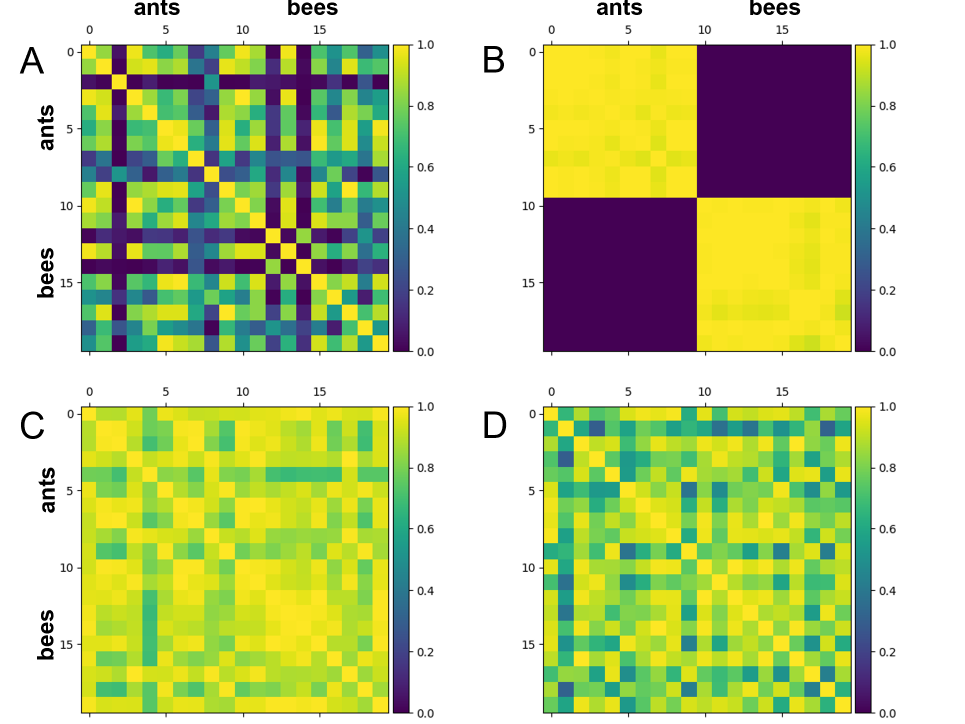
Figure 2. Gram matrices for mutual data overlap (i.e., | (cid:104) x | x (cid:48) (cid:105) | 2 ) in Hilbert space for 10 ant and 10 bee samples from the Hymenoptera dataset where 0 and 1 correspond to no and perfect overlap, respectively. In each case, 512 ResNet features (corresponding to 1024 trainable linear parameters) were used. The stronger the separation between the purple tiles (bees) and the yellow tiles (ants), the better the model’s ability to classify. The Hymenoptera dataset’s default train-test split was used for these results. The PennyLane software package was used to train the embedding [40]. ( A ) Mutual data overlap in Hilbert space for training set datapoints at optimization step 0. ( B ) Mutual data overlap in Hilbert space for training set datapoints at optimization step 1500. ( C ) Mutual data overlap in Hilbert space for test set datapoints at optimization step 0. ( D ) Mutual data overlap in Hilbert space for test set datapoints at optimization step